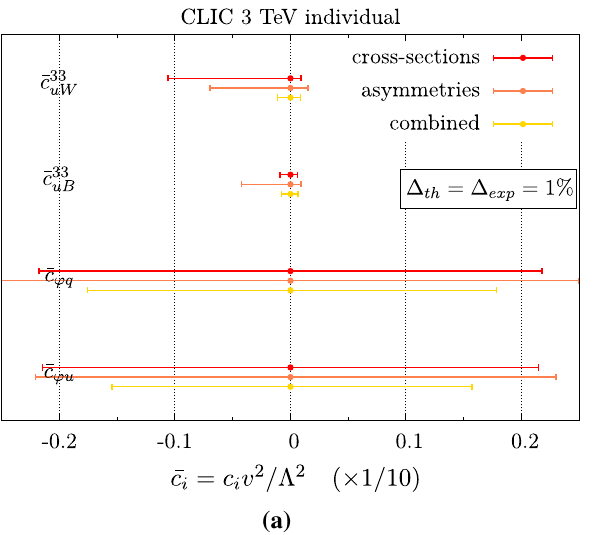
Fig. 7 95%confidencerangesfortheoperatorsweconsiderhere,from √ s =3TeV,assuming1%theoreticalandexperimental CLICrunningat uncertainties, by fitting to cross-sections, asymmetries, and the combi-